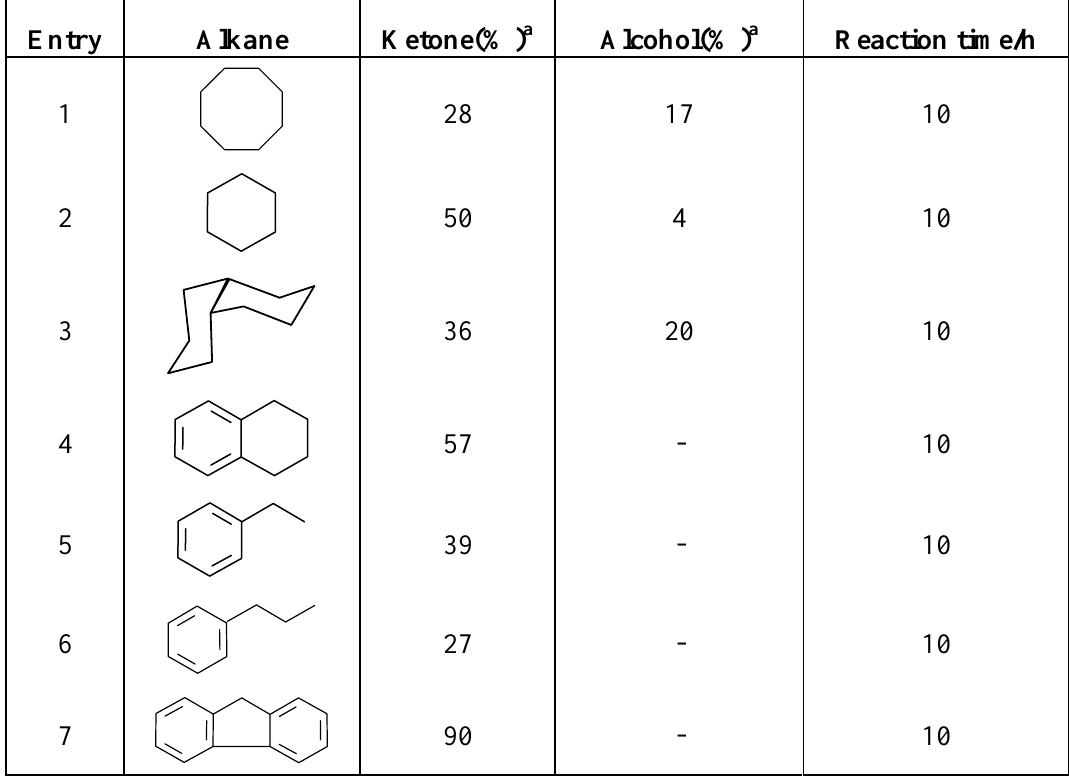
catalyzed by Mn(Br TPPS)- 4 8